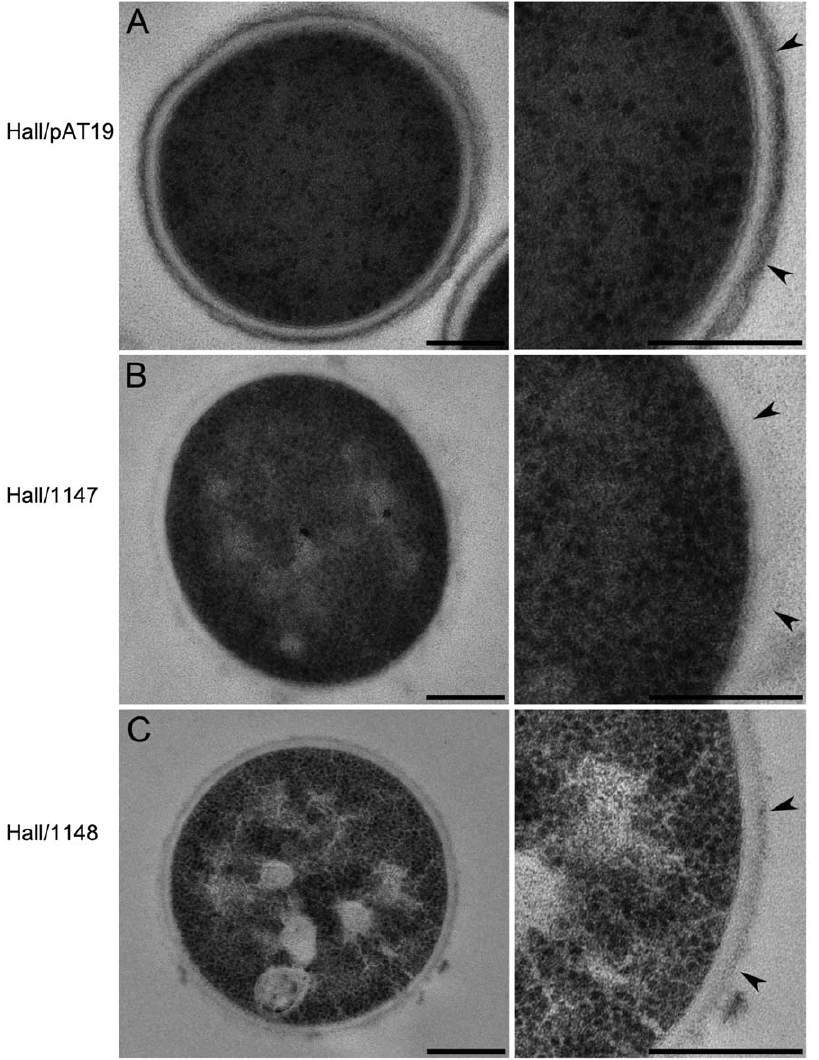
Figure 4. Ultrastructural morphology of Hall/pAT19, Hall/1447, and Hall/1148. Bacteria from a 5 h culture in TGY were treated by high pressure and freeze substitution and then observed by electron microscopy. Hall/pAT19 (A) showed a well delineated wall, whereas in Hall/1147 (B) and Hall/1138 (C) the bacterial wall is transparent, almost invisible. In addition, Hall/1148 (C) showed numerous transparent inclusions. All scale bars represent 200